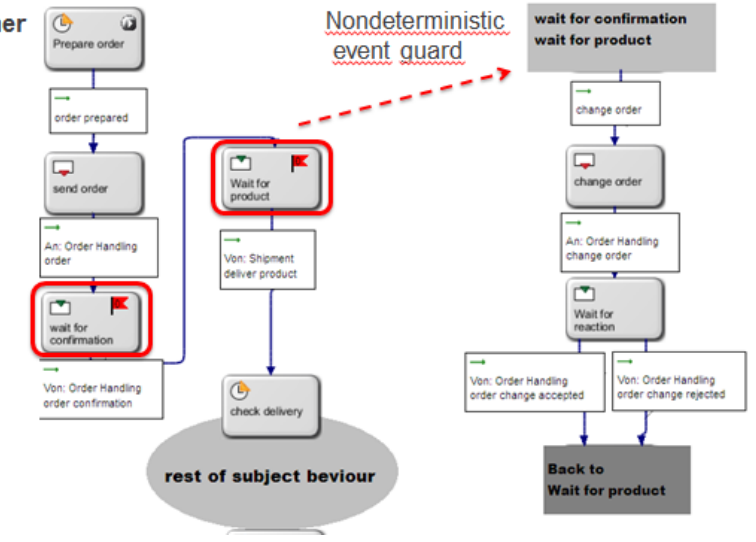
Figure 13. Refinement of modifications in the Behavior Diagrams of the subject